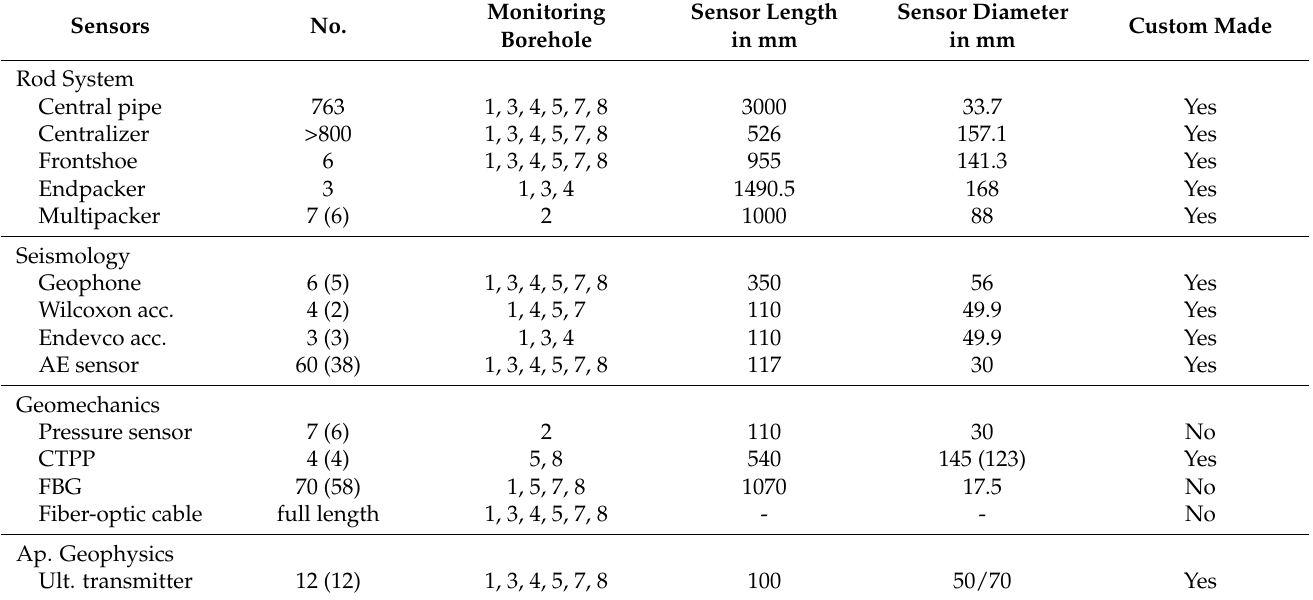
Table 1. Overview of equipment installed in long monitoring boreholes for the BRP experiment. The monitoring network is accompanied by additional sensors installed in short boreholes or platforms in the main tunnel. Both the number of installed sensors is given as well as the number of working sensors in early 2022 (in brackets). Details on the sensors including the custom-made sensor adaptions and reasons for sensor failure are discussed in Sections